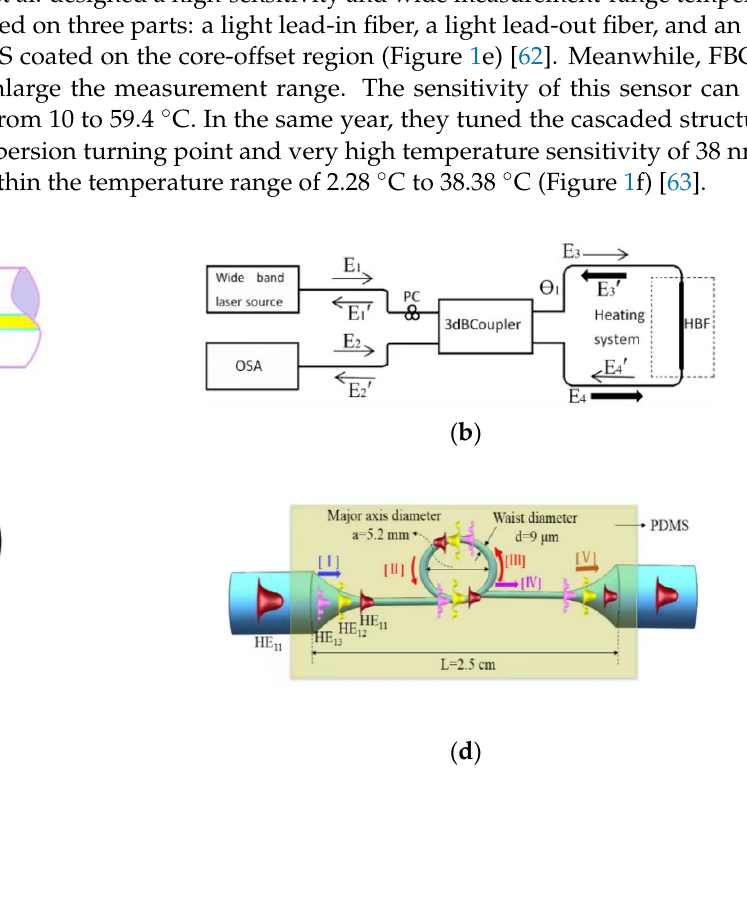
Figure 1. ( a ) Schematic diagram of the dislocation fiber MZI-based sensor [48]. ( b ) Schematic of HBEF sensor based on a Sagnac loop [51] . ( c ) Schematic diagram of an SI based on a PMF with a circle [53]. ( d ) Diagrammatic sketch of the PDMS-coated microfiber sensors [60]. ( e ) The sensing probe with cascaded MZI and FBG [62]. ( f ) Schematic of temperature measurement system [63]. 3.2. Salinity Salinity is also one of the important physical parameters in the ocean. The commonly used fiber-optic salinity sensors also include FG, interferometric OFS, and MS types. In this section, salinity sensing and measurement based on these devices are described. 3.2.1. Salinity Sensing and Measurement Based on FG Usually, FBG without coating is only sensitive to TP. By coating specific materials on FBG, salinity sensing can be realized and the problem of cross sensitivity of multi-param- eters can be solved. In addition, LPG can also be used to measure ocean salinity. In 2017, Yang et al. demonstrated a highly sensitive fiber-optic salinity sensor synergistically com- bining LPG and stimuli-responsive polyelectrolyte multilayers, with sensitivity of 36 nm/M [64]. Soon after, they demonstrated a highly sensitive and fast-response-time fiber- optic salinity sensor that incorporates LPG and ion-strength responsive hydrogels with sensitivity of 125.5 pm/‰ [65]. However, the long-term stability of the sensitizing coating remains to be further investigated. 3.2.2. Salinity Sensing and Measurement Based on an Interferometric OFS MZI and SI are interferometric fiber optic sensors commonly used in measuring sa- linity individually. In terms of MZI, Meng et al. proposed a sensor based on the multi- mode interference effect in 2013 [66]. The sensor was fabricated by splicing a section of